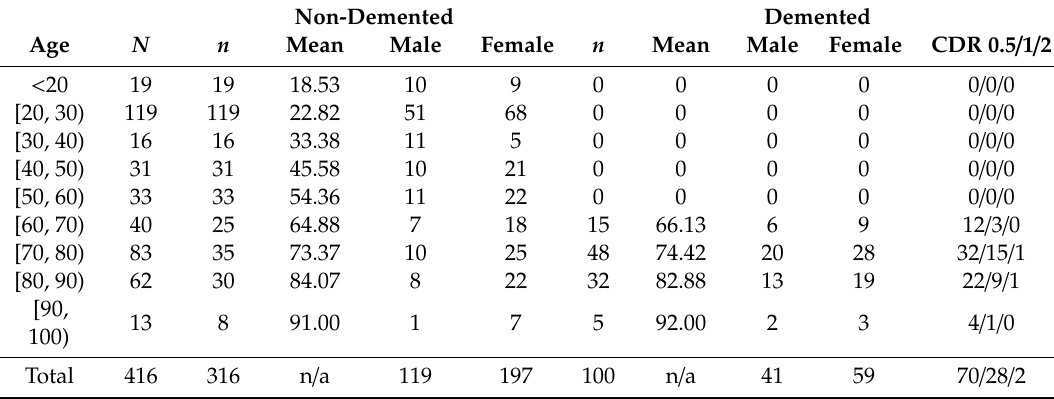
CDR—Clinical Dementia Rating.